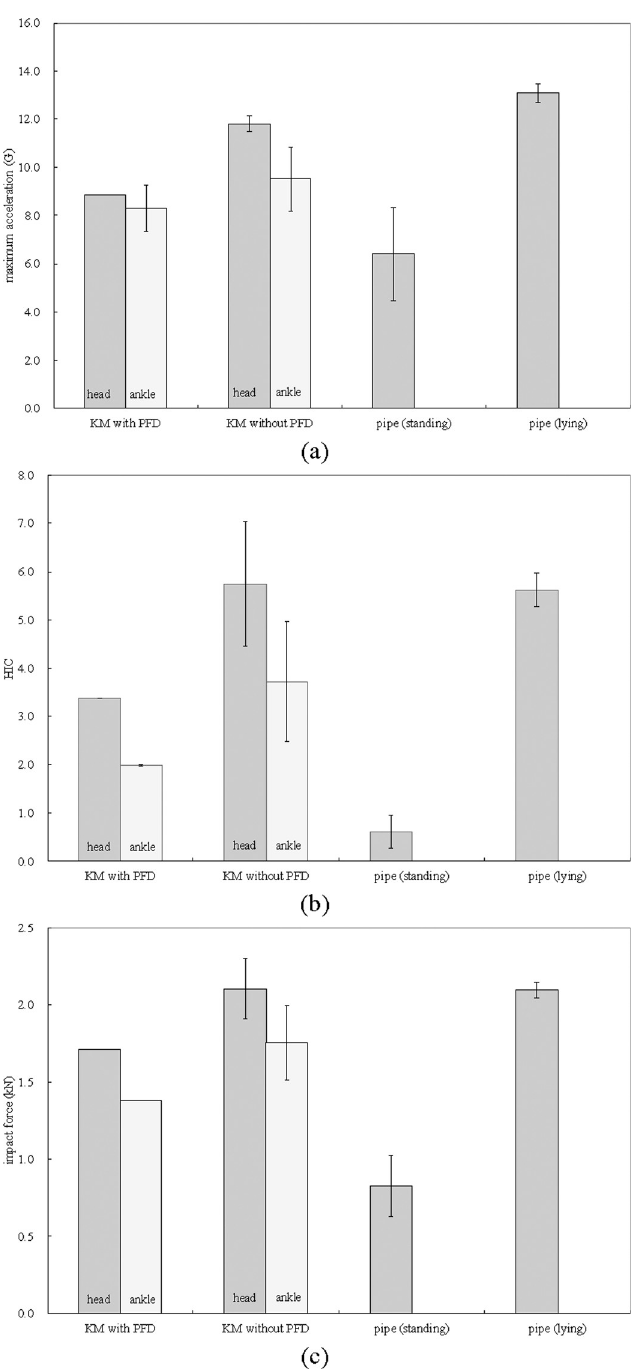
Fig 7. Impact-force indexes owing to collision: (a) Maximum acceleration (b) HIC (c) Average impact force. low. While these calculations were conducted using the values 20.0 and 25.4 kg for m in Eq (2), using higher weights (representative of adults’ weight) will not affect the overall conclusion for the impact force aspect. Considering the values of acceleration, HIC, and average impact force, it can be concluded that a collision with a concrete wall under the given conditions is not likely